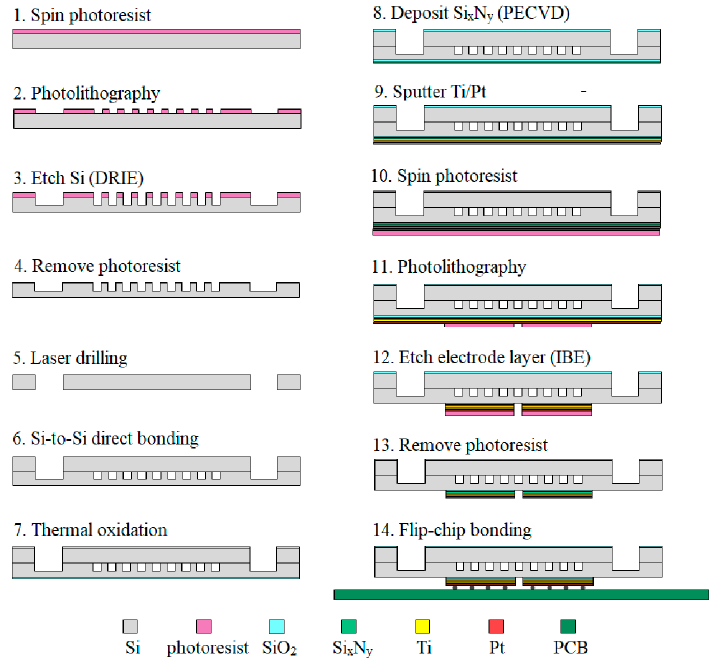
Figure 3. Fabrication process of the test chips.